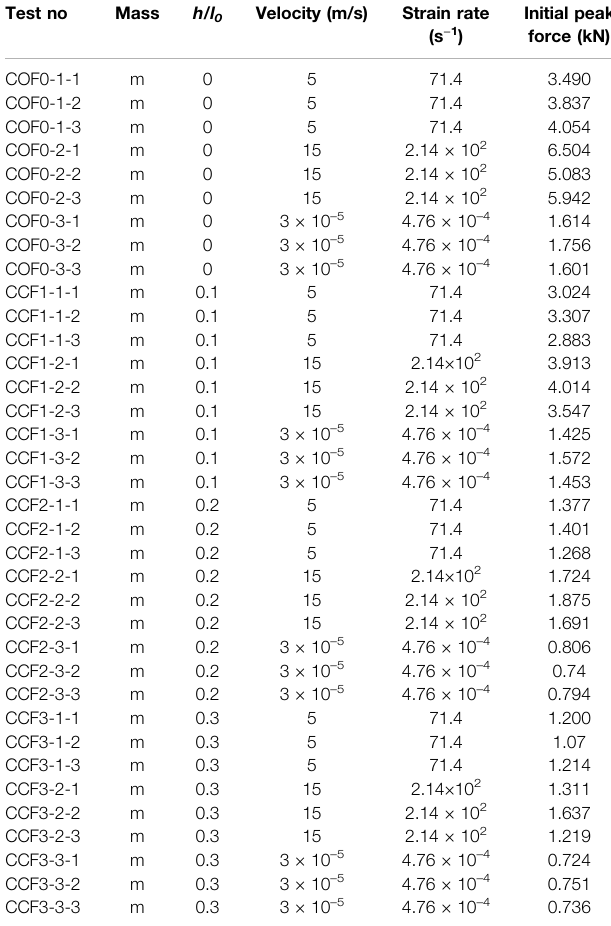
TABLE 1 | Summary of the tests on the foams and the